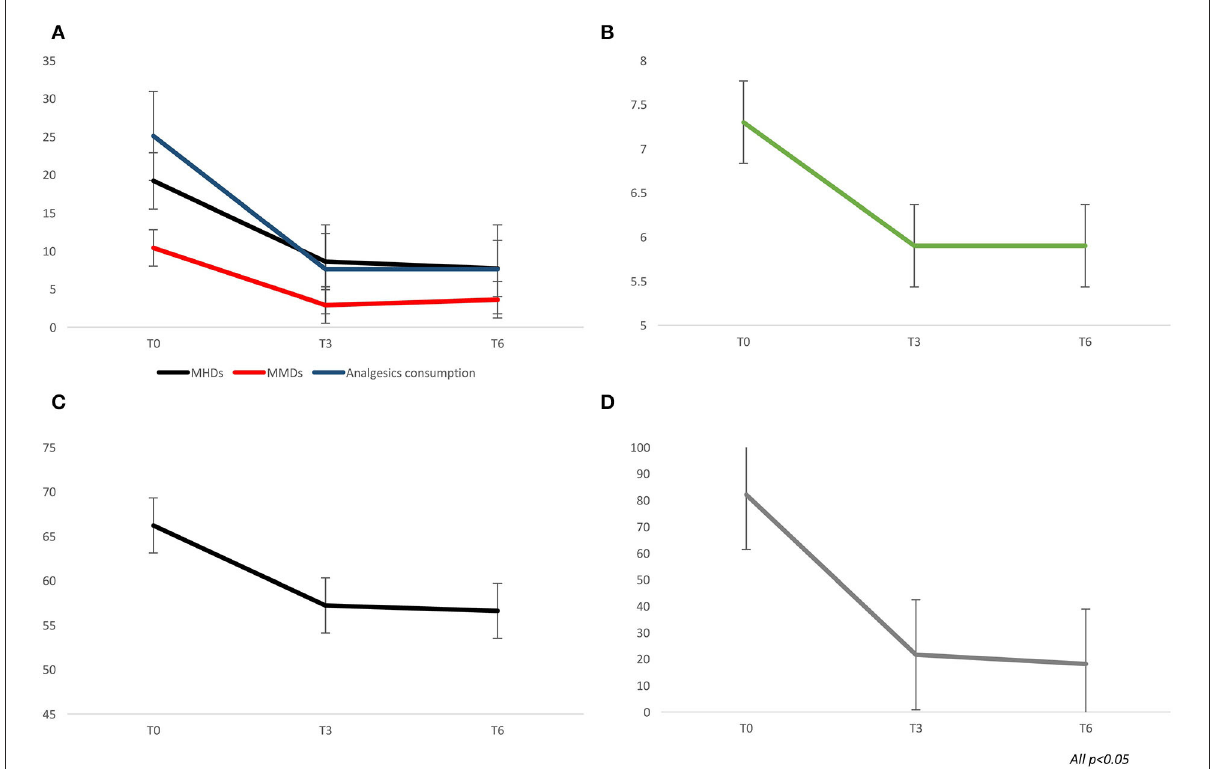
FIGURE1 Migraine outcome during treatment with galcanezumab, at three (T3) and six (T6) months of treatment. (A) monthly headache and migraine days, analgesics consumption. (B) pain intensity–Numerical rating scale scores. (C) HIT-6 scores. (D) MIDAS